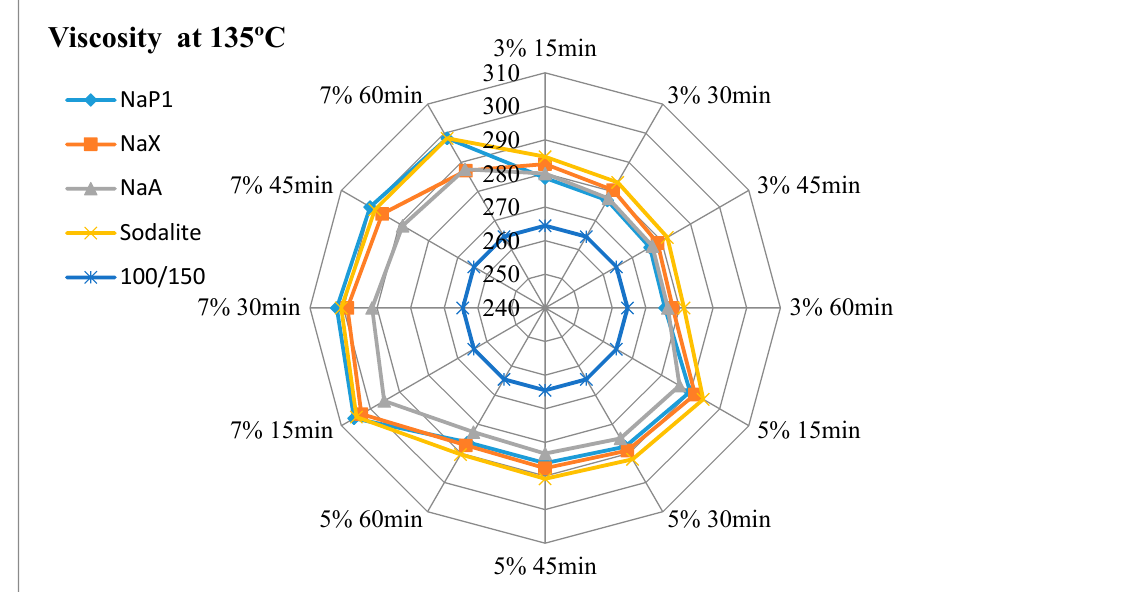
Figure 4. The results of dynamic viscosity tests for 100/150 asphalt with the addition of zeolites measured at 135 °C.